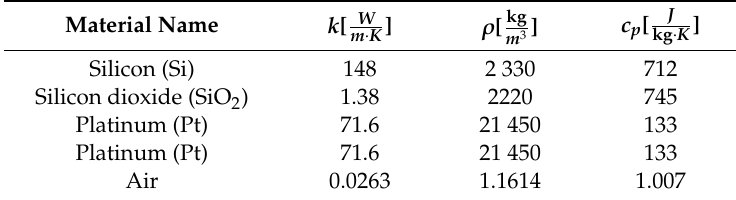
Table 1. Considered material parameters’ values